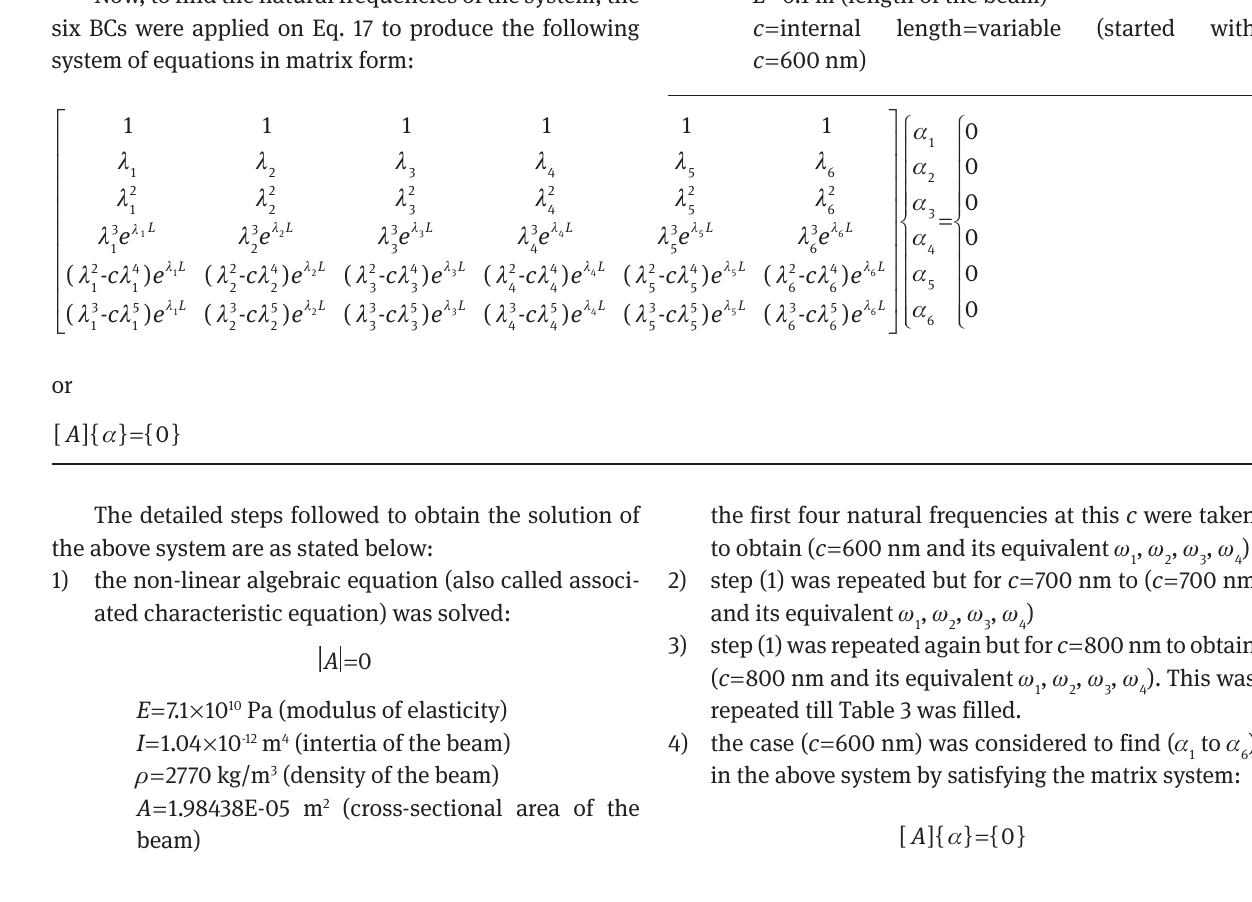
Table 3: Frequencies for cantilever beam in gradient material